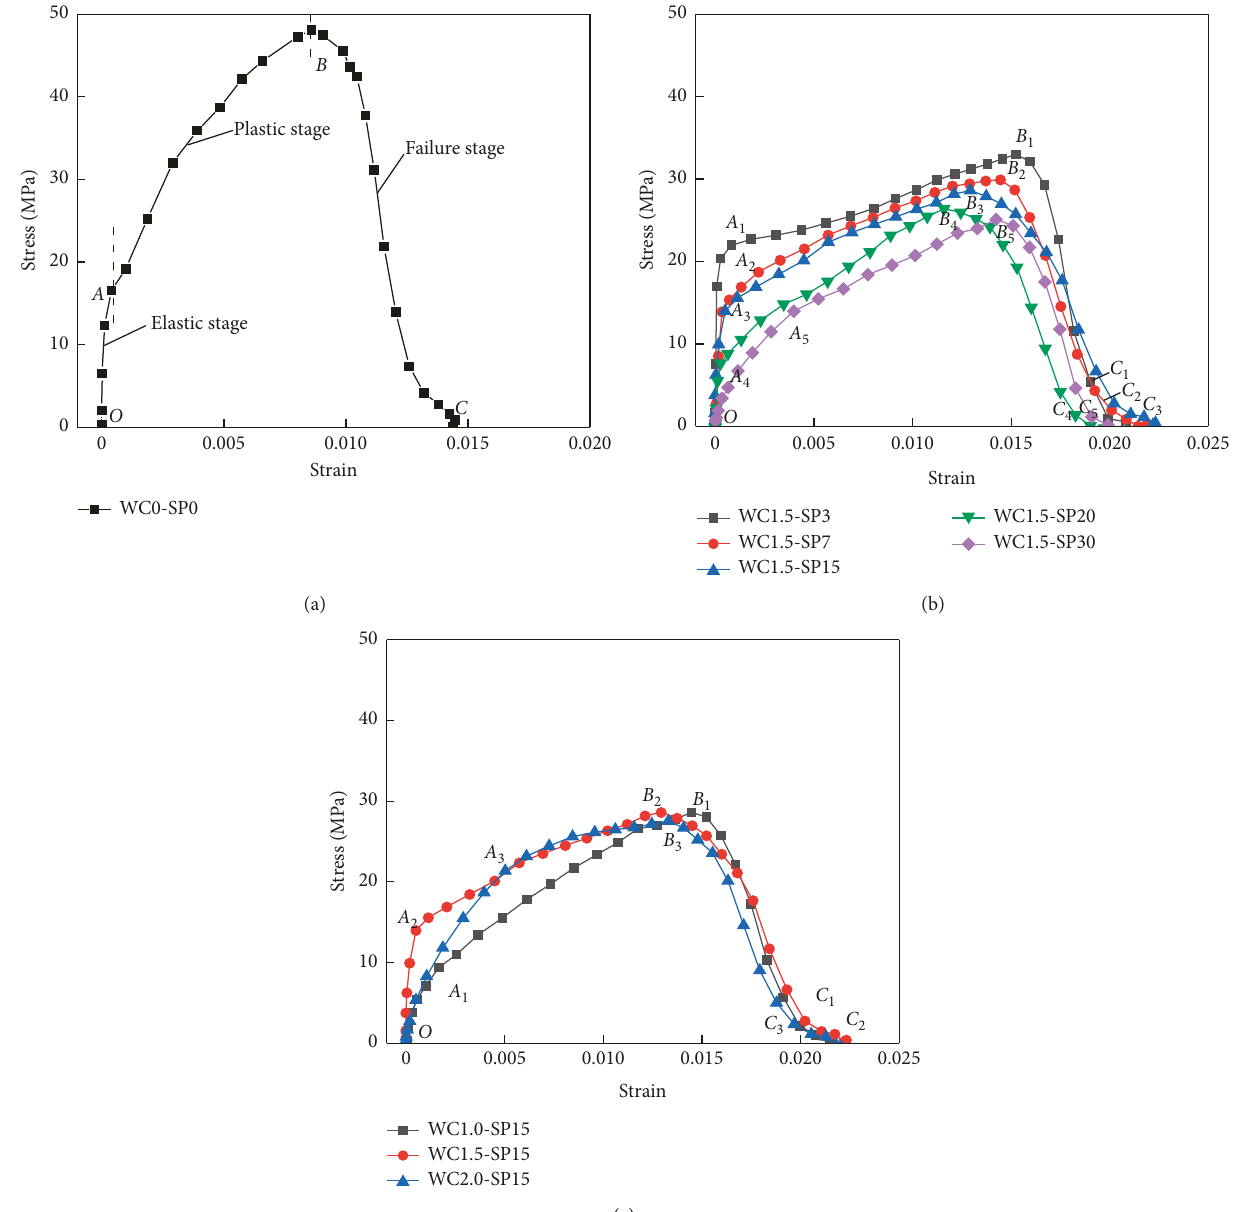
Figure 10: Dynamic stress-strain curves for ready-mixed concrete with 0.9MPa impact pressure in uniaxial load